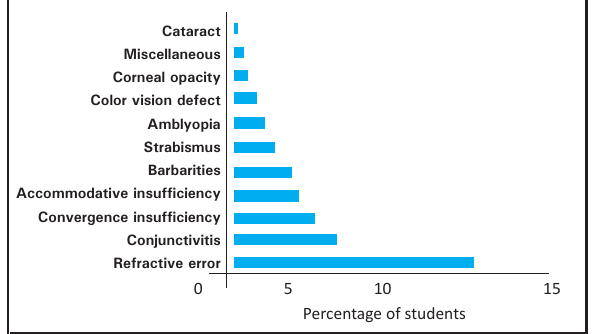
Figure 2. Distribution of ocular